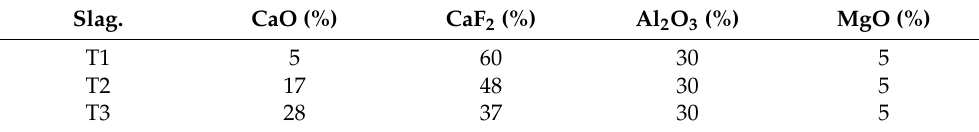
Table 1. Composition of pre-melted slag used in weight gain experiment.